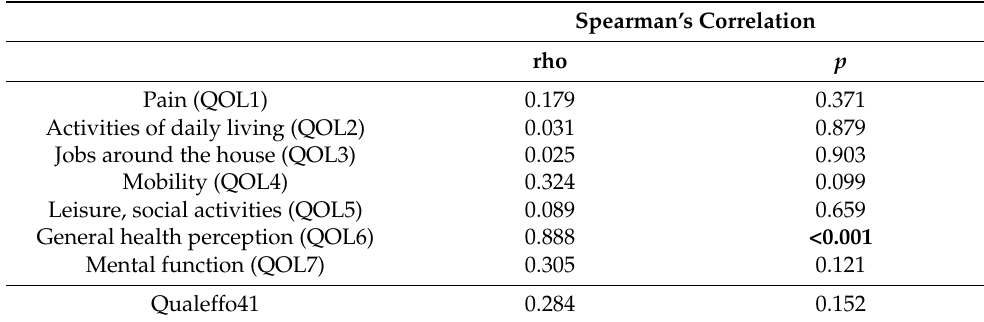
Table 4. Correlations between pain intensity and the quality of life in Group 1 (participants with osteoporosis).